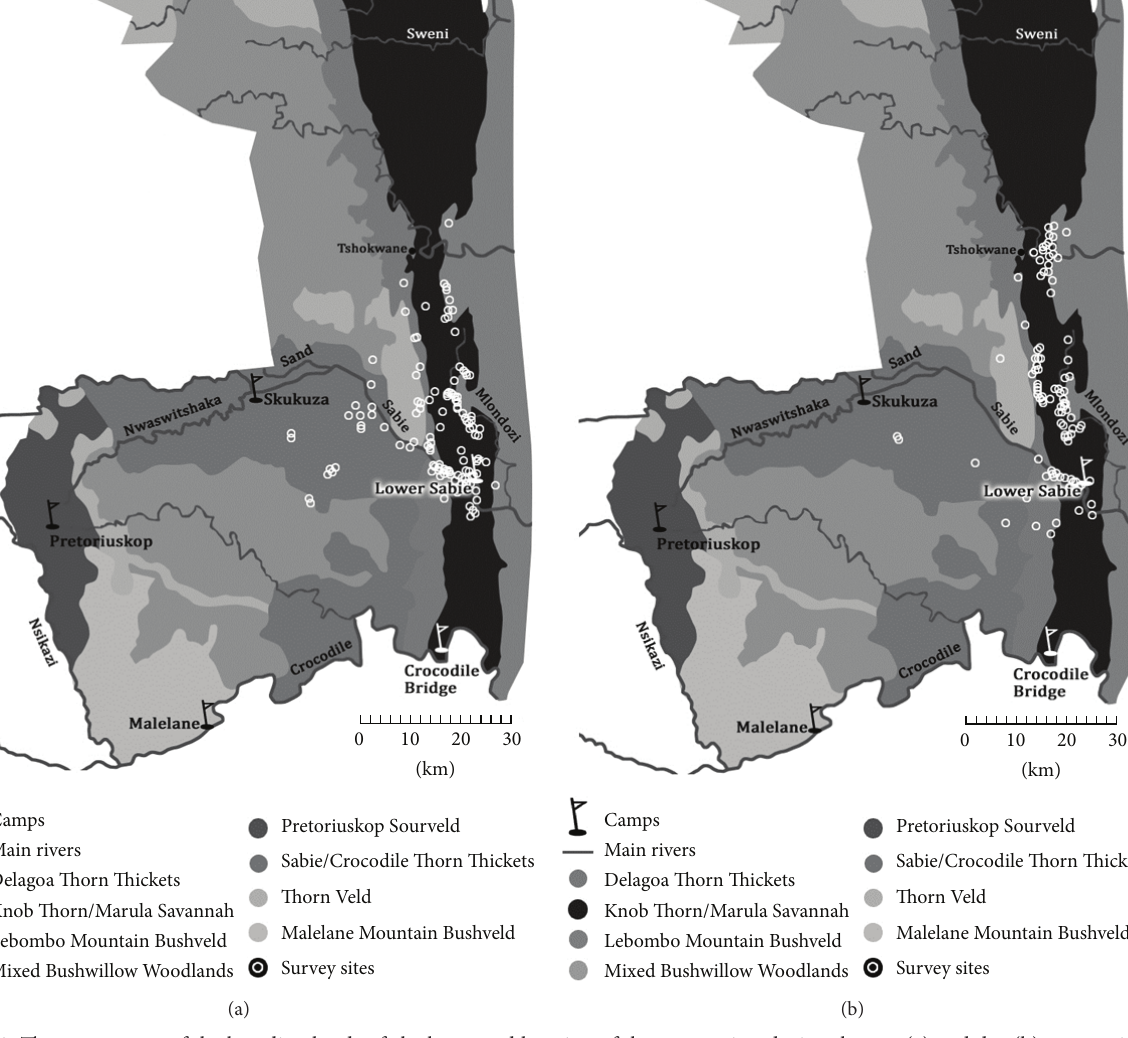
field observations on feeding behaviour of elephants on the savanna lands in the Murchison Falls National Park region of